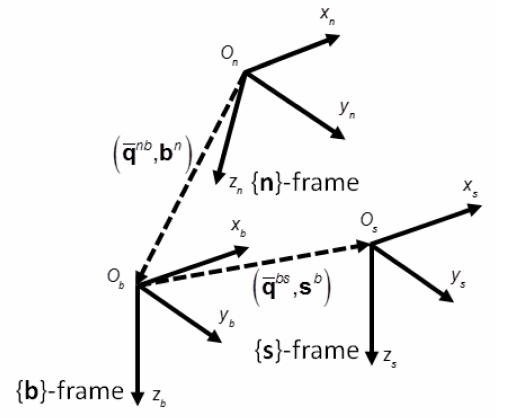
Figure 1. The reference frames involved in the experimental